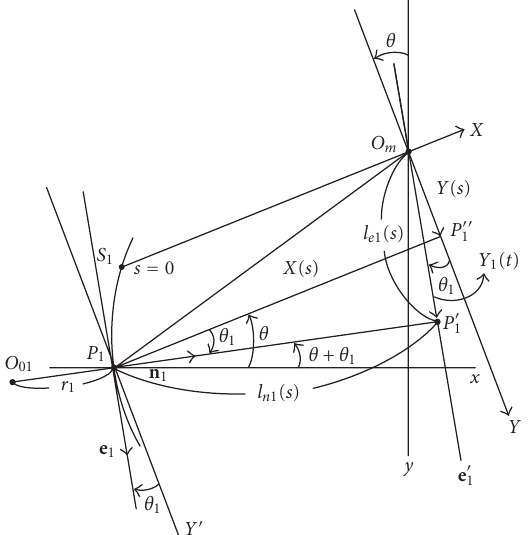
Figure 8: Physical and geometrical meanings of key variables l n 1 ( s ) and l e 1 ( s ) defined in relation to the object contour c ( s ) expressed in terms of length parameter s of the